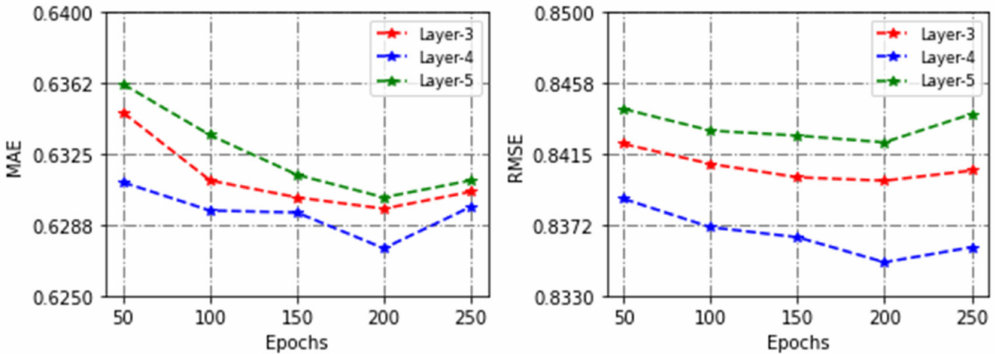
Figure 5. Comparison between